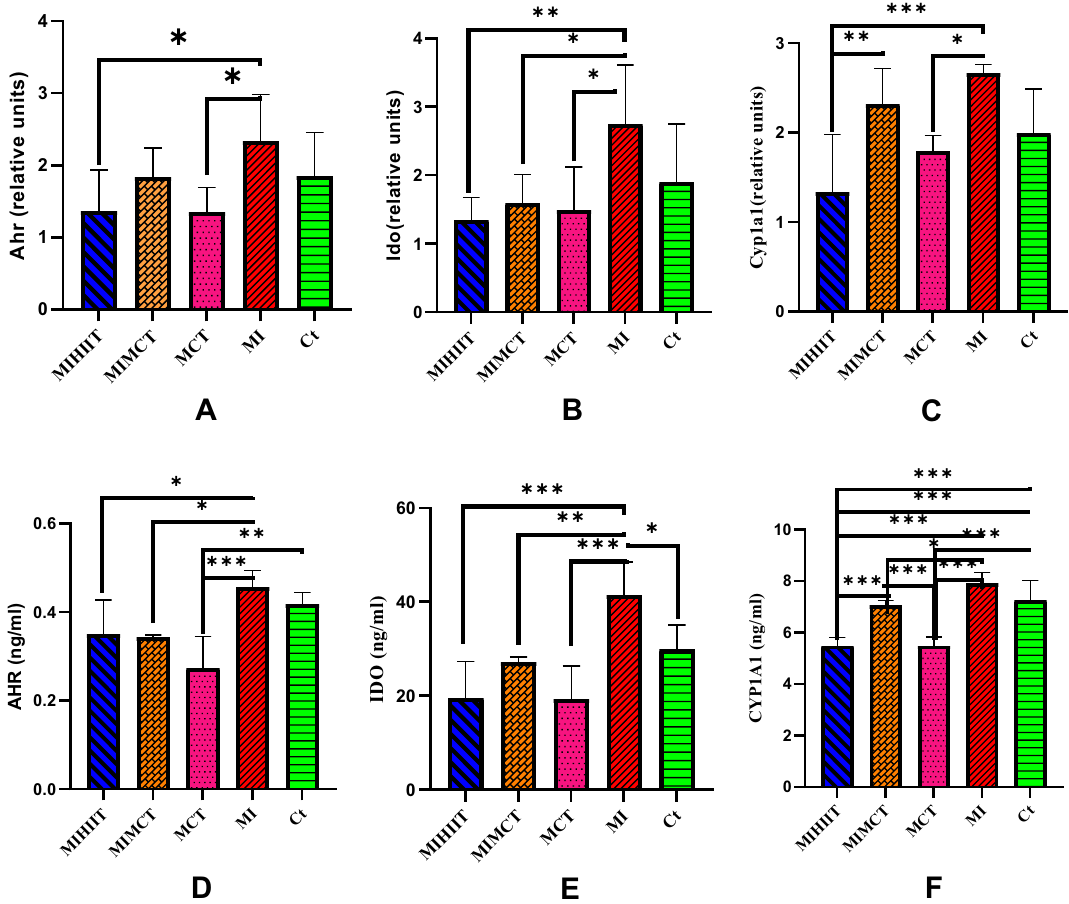
Figure 2. Ahr ( A ), Ido1 ( B ), and Cyp1a1 ( C ) gene expression, and AHR ( D ), IDO1 ( E ), and CYP1A1 ( F ) protein levels in the heart tissue of rats. Gene expressions and protein levels were increased in the MI condition and training showed decreasing effects in them. Abbreviations: Ct control group, MI the group with occlusion of the left coronary artery, MICT the group treated with moderate intensity of continuous training, MIMCT rats with left coronary artery occlusion treated with moderate intensity of continuous training, MIHIIT rats with left coronary artery occlusion treated with high-intensity interval